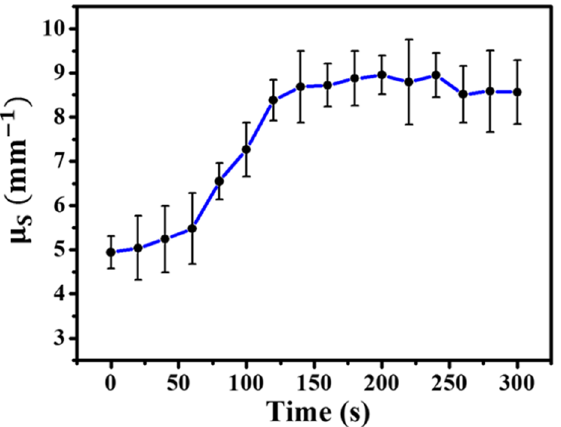
Figure 3. Variation of scattering coefficient with demineralization time. This figure was adapted from [81] and was created with Microsoft Word (Microsoft Corp., Redmond, WA, USA).